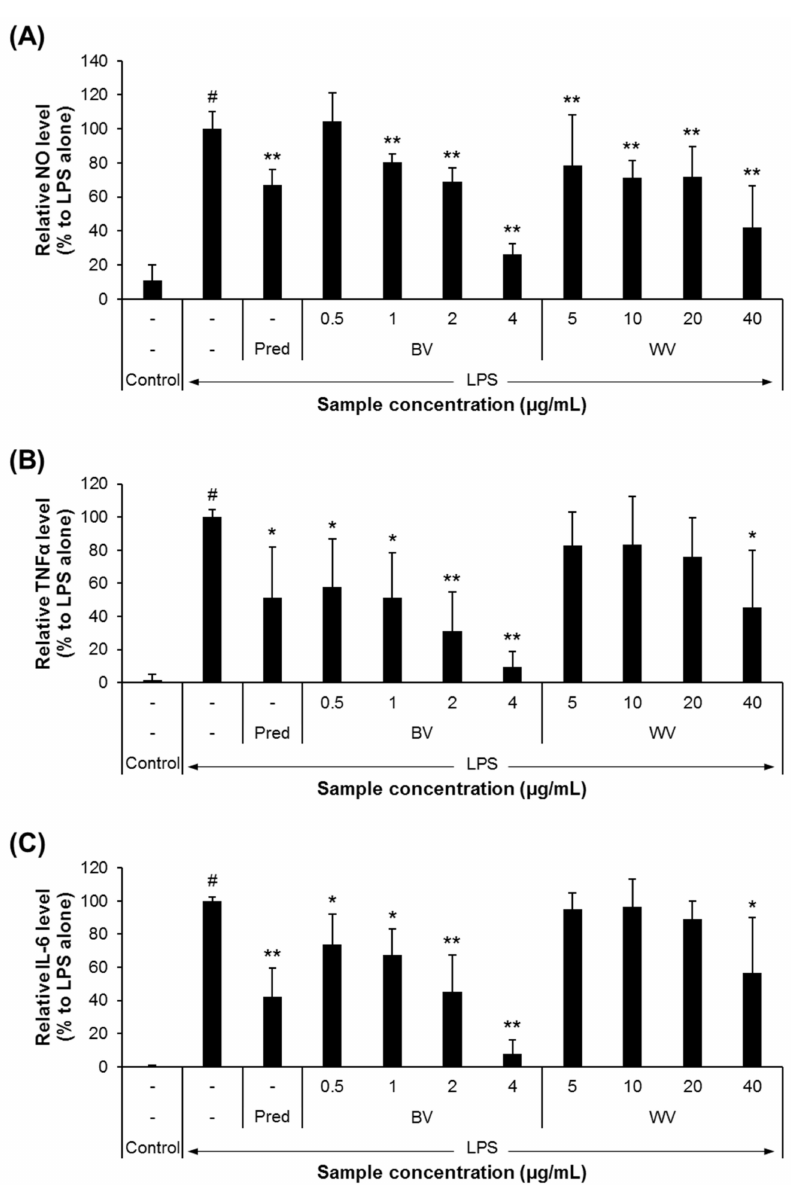
Figure 2. WV decreased the production of nitric oxide (NO) and secretions of proinflammatory cytokines from lipopolysaccharide (LPS)-treated BV-2 cells. ( A - C ) BV-2 cells were plated into a 6-well plate at a density of 5 × 10 5 cells/well, activated with 10 ng/mL of LPS, and treated with either WV or BV at the designated concentrations for 18 h. Prednisolone (Pred, 10 µ M) was used as the positive control. The culture media were collected and subjected to the quantification of NO ( A ), tumor necrosis factor α (TNF α ) ( B ), and interleukin-6 (IL-6) ( C ) levels. Treatment of LPS-stimulated BV-2 cells with either WV at ≥ 5 µ g/mL or BV at ≥ 1 µ g/mL significantly decreased NO production. In addition, WV at >20 µ g/mL or BV at ≥ 0.5 µ g/mL reduced the levels of proinflammatory cytokines TNF α and IL-6 secreted from LPS-stimulated BV-2 cells. N = 5; error bars, mean ± SD. Statistically significant differences between the means were analyzed by Student’s t -test. Hashtags ( # ) indicate a significant difference compared to the control ( p < 0.05). Asterisks (*) indicate a significant difference compared to the LPS alone treatment (*, p < 0.05; **, p <